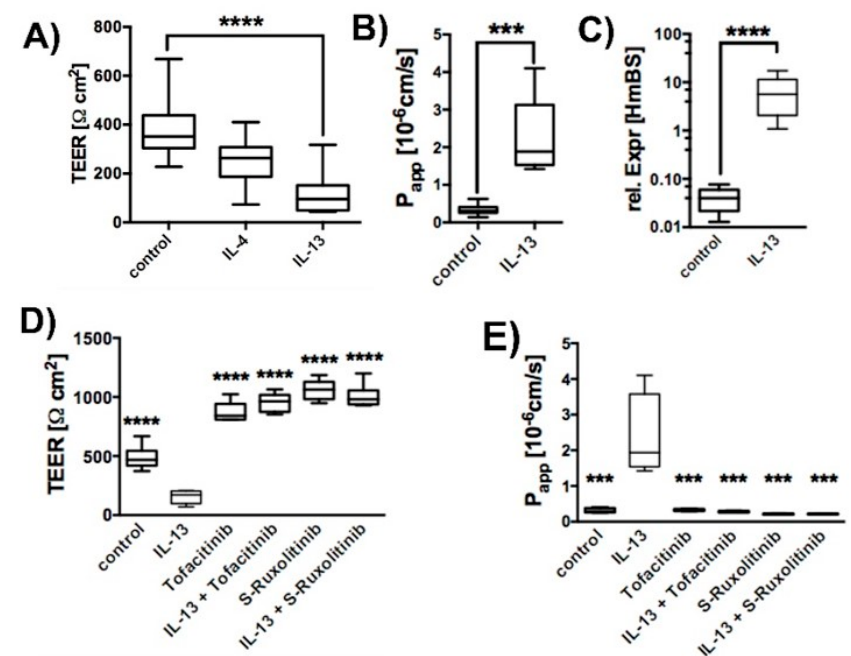
Figure 1. IL-13 increased paracellular permeability. Human tracheal epithelial cells were cultivated at air-liquid interface conditions in the absence (control) and presence of 10 ng/mL IL-13 (IL-13). Box plots summarize data as median values, the boxes represent percentiles, the whiskers indicate the minimum/maximum. ( A ) Response of human tracheal epithelial cells to T H 2 cytokines IL-4 and IL-13 (10 ng/mL each). Both cytokines reduced TEER. However, TEER reduction by IL-4 did not reach significance (Kruska-Wallis test with Dunn’s correction for multiple testing, p = 0.086, IL-4 ( N = 8) versus control cells (control), N = 20). IL-13 reduced TEER significantly (Kruska-Wallis test with Dunn’s correction for multiple testing, p < 0.0001, IL-13, N = 17 versus control, N = 20). ( B ) IL-13 increases apparent permeability coefficient (P app ) for the small molecular marker sodium fluorescein (Mann-Whitney test, p = 0.0002, N = 7). Inhibition of JAK/STAT pathway by Tofacitinib and S-Ruxolitinib abolishes IL-13 induced effects on ( C ) Relative Expression of Muc5ac in human tracheal epithelial cells. Upregulation of mucus production was confirmed by detecting Muc5ac upregulation in IL-13 treated epithelia. ( D ) TEER of control epithelia (control), epithelia cultivated in the presence of IL-13 (IL-13), 2.5 µM Tofacitinib (Tofacitinib) or S- Ruxolitinib (S-Ruxolitinib) and in the presence of IL-13 + Tofactinib or IL-13 + S- Ruxolitinib. (all versus IL-13, ANOVA with Holm-Sidak correction for multiple testing, p < 0.0001, N = 6) and on ( E ) P app (all versus IL-13, ANOVA with Holm-Sidak correction for multiple testing, N = 4, control p = 0.0003, Tofacitinib p = 0.0003, Tofacitinib + IL-13 p = 0.0002, S-Ruxolitinib p = 0.0002 and S-Ruxolitinib + IL-13 p = 0.0002). *** and **** indicate p < 0.001 and p < 0.0001, respectively.